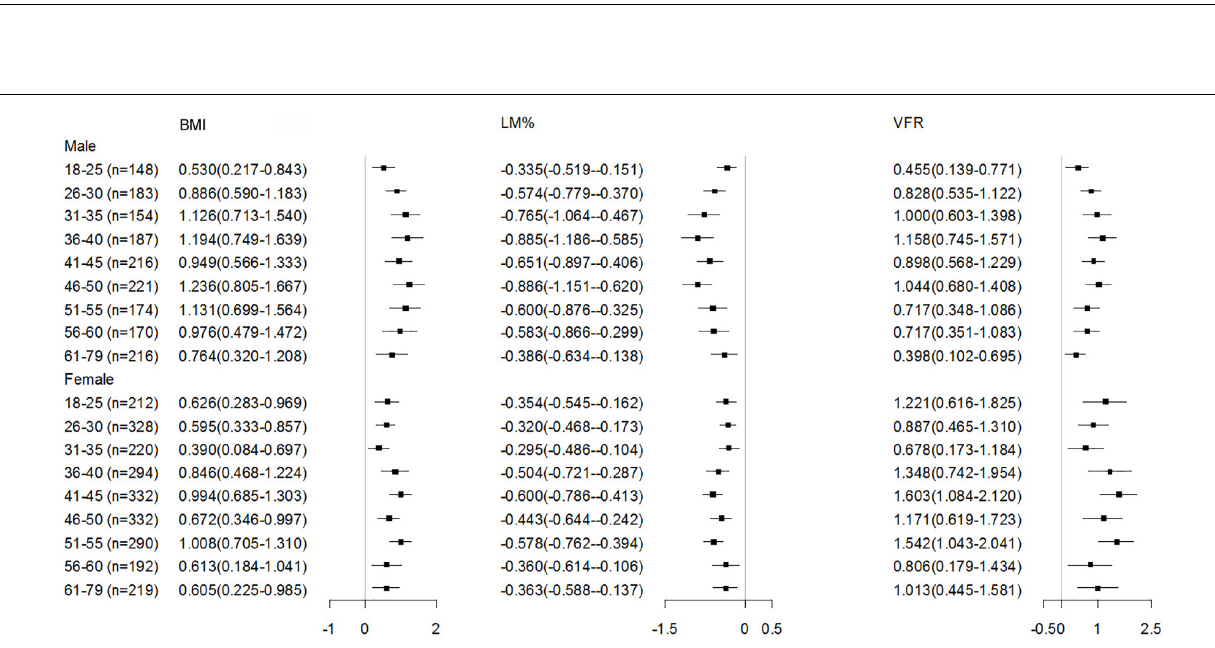
FIGURE 3 | Adjusted regression coefficients of body composition indices by DBP in the subjects b (95% CI)was obtained from multiple linear regression analysis, adjusted for education, smoking and drinking status, and residential location; BMI, body mass index; LM%, lean mass percentage; VFR, visceral fat rating; SBP, systolic blood